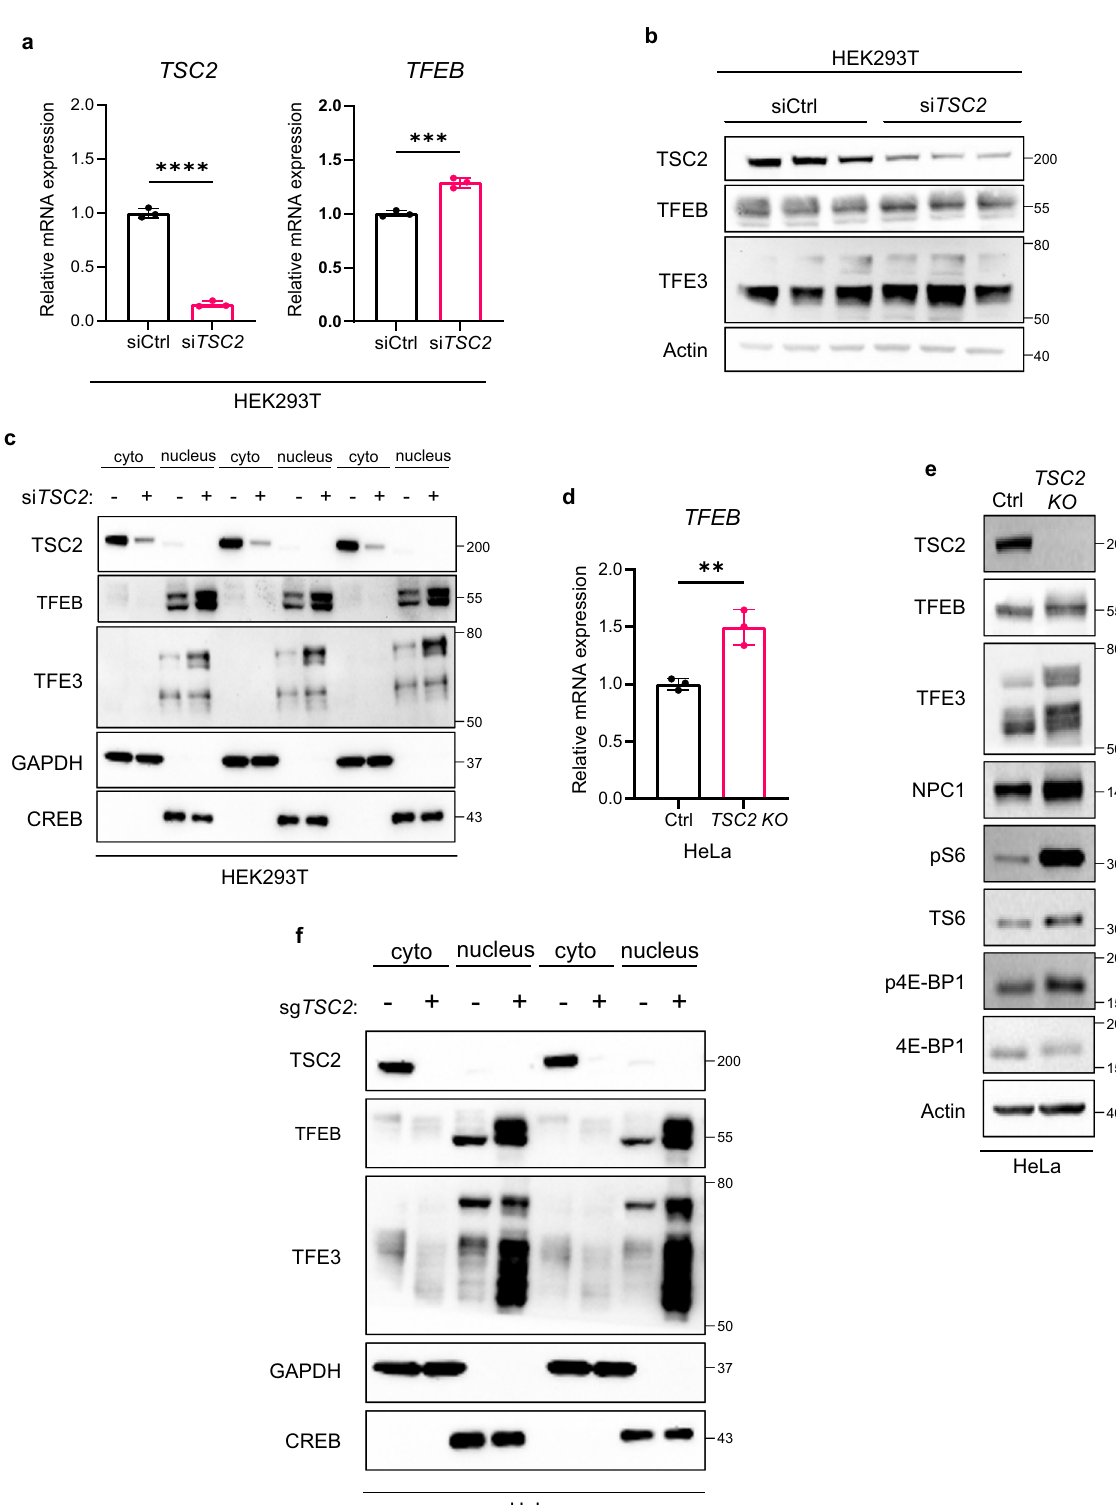
siRNA (Fig. 5h, i). Further work using CRISPR-mediated knockout of TSC2 and FLCN will be important to complement these siRNA-based fi ndings. Activation of RAGC GTPase is necessary and suf fi cient to localize TFEB into the cytoplasm in TSC2 -de fi cient cells . Our data showing that knockdown of either FLCN or TSC2 has similar